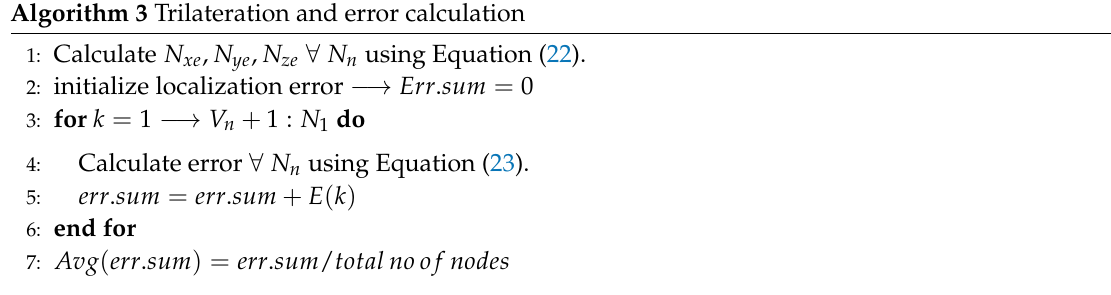
Algorithm 3 Trilateration and error calculation